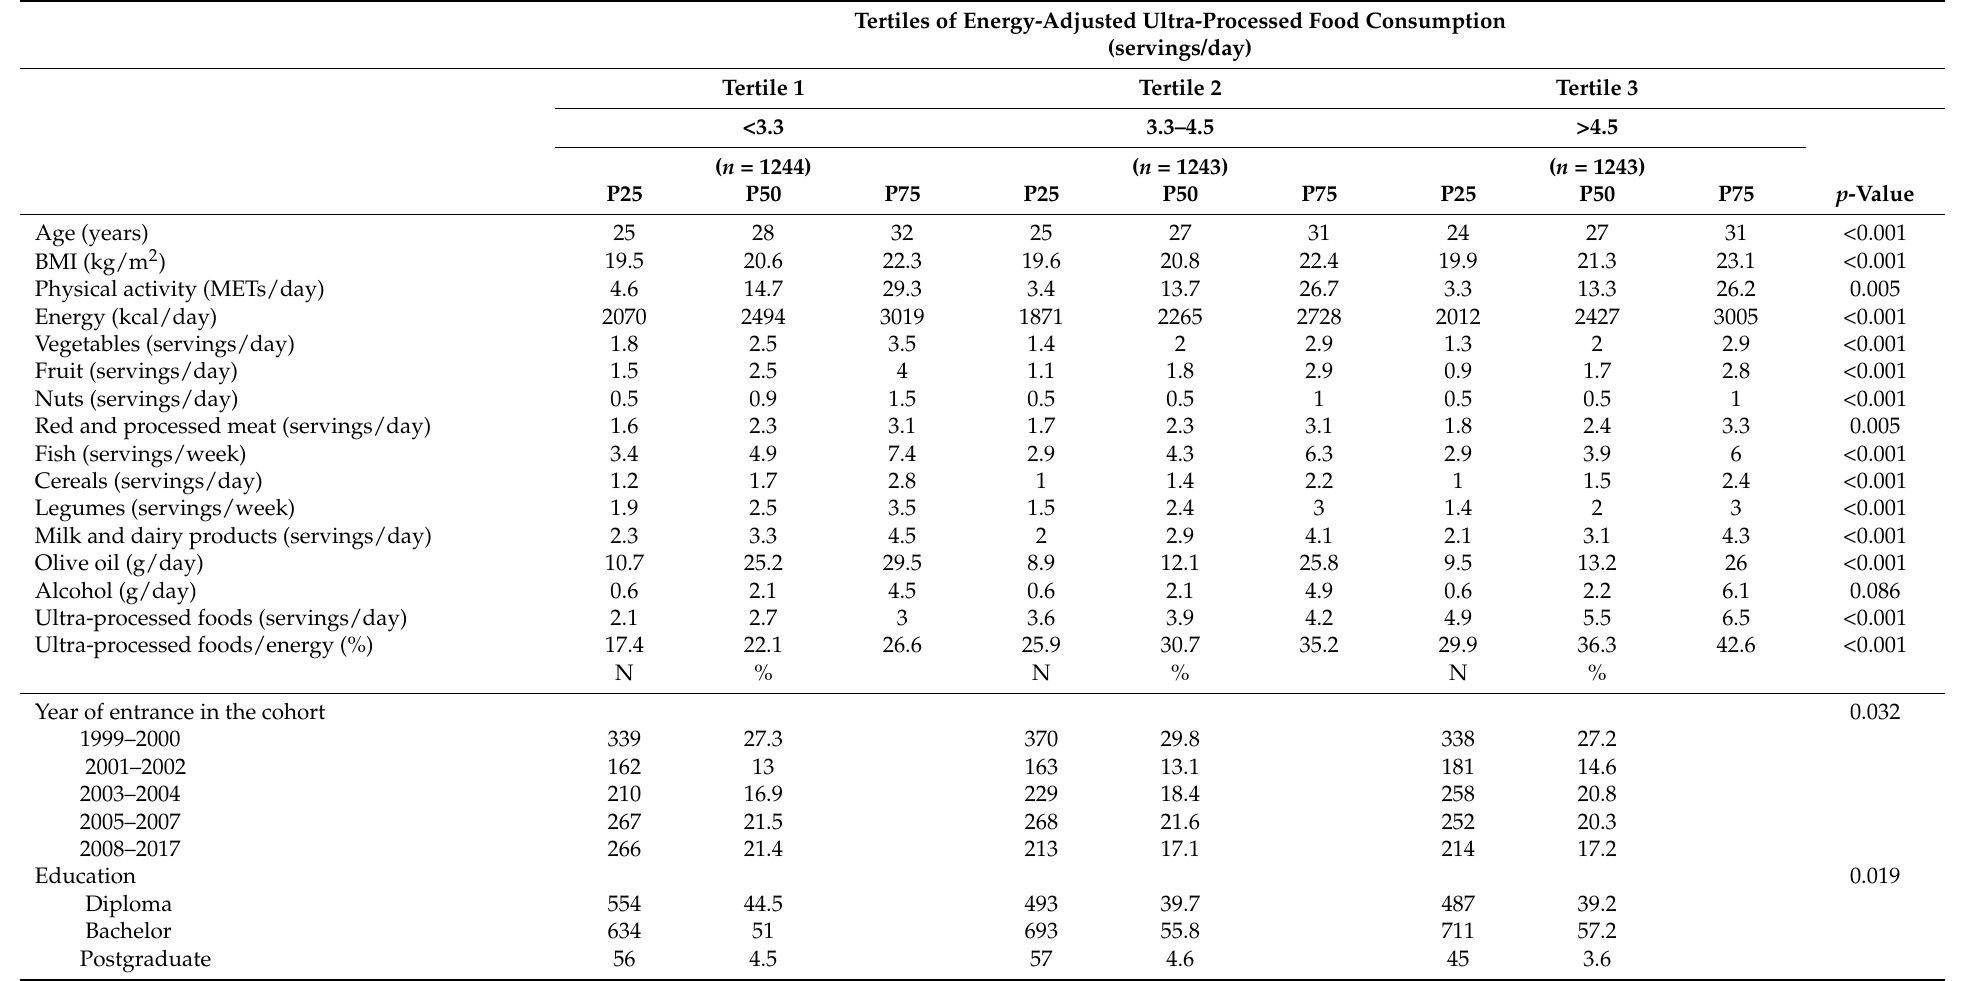
Table 2. Characteristics of the recruited subjects across tertiles of energy-adjusted ultra-processed food consumption and in the total sample. Tertiles of Energy-Adjusted Ultra-Processed Food